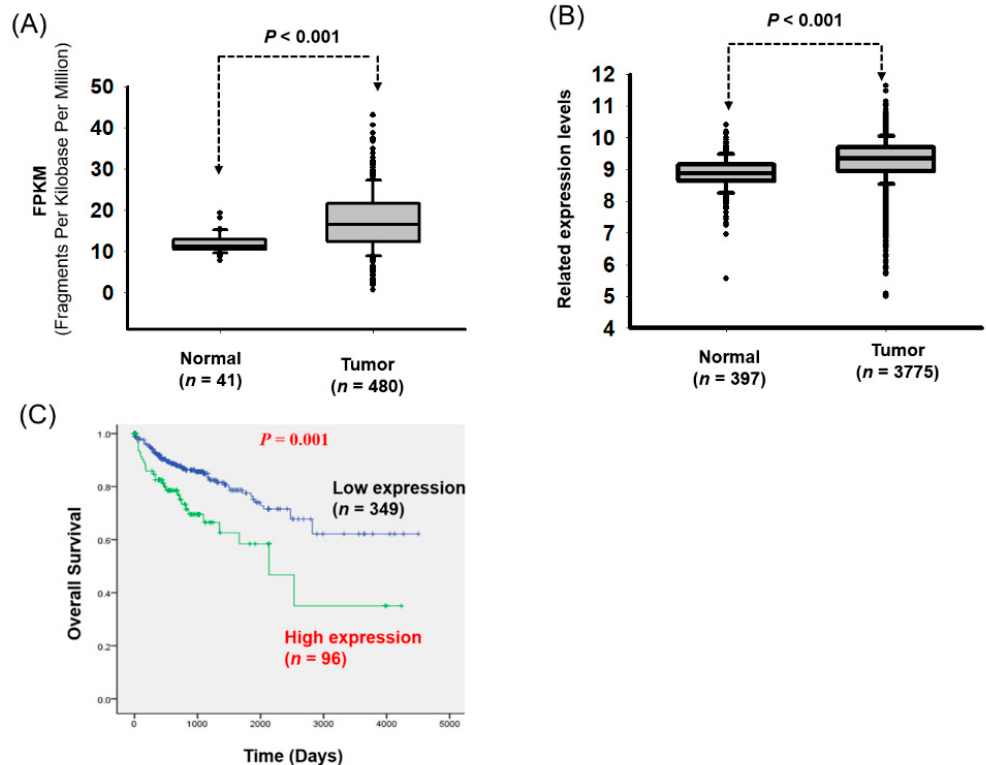
Figure 1. High LOC550643 expression was correlated with poor prognosis in patients with CRC. LOC550643 expression level were examined through the analysis of ( A ) The Cancer Genome Atlas (TCGA) database and ( B ) the Gene Expression database of Normal and Tumor tissues (GENT). ( C ) Kaplan–Meier analysis revealed the association of high LOC550643 expression and poor survival in patients with